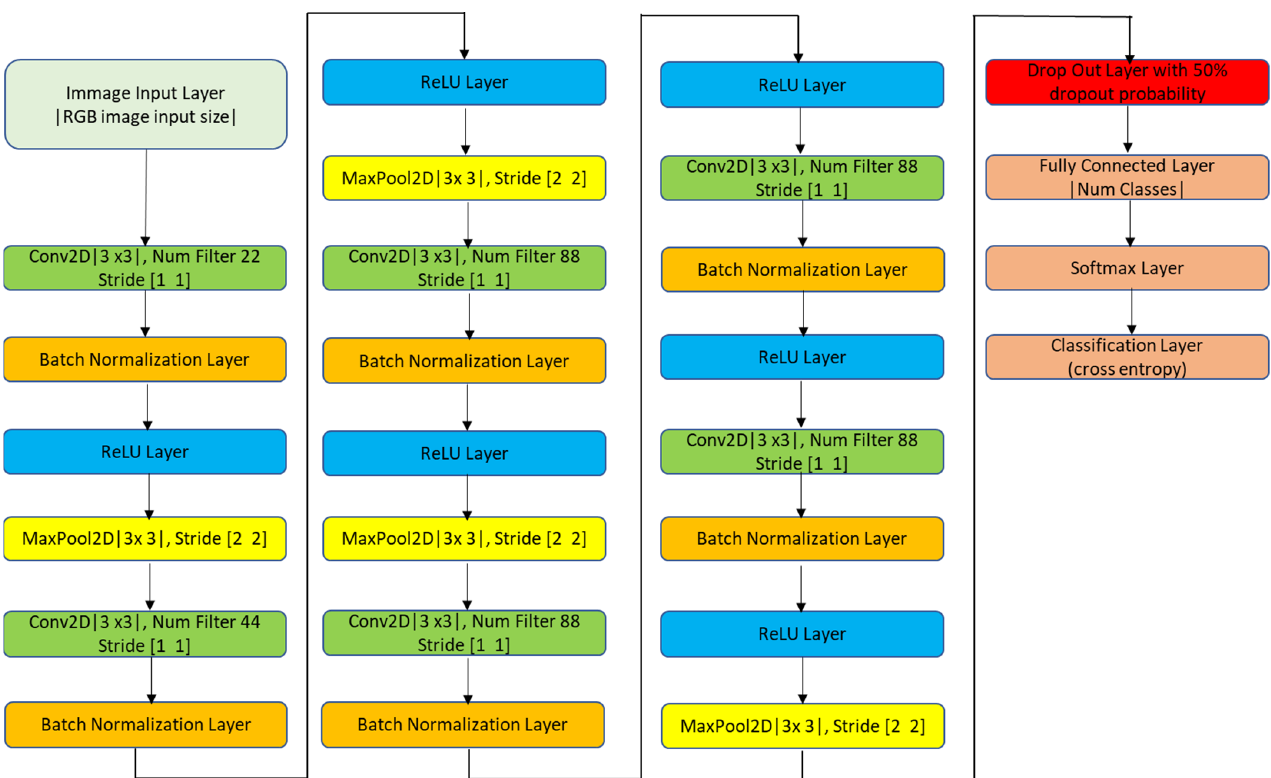
Figure 5. Architecture of proposed convolutional neural network.